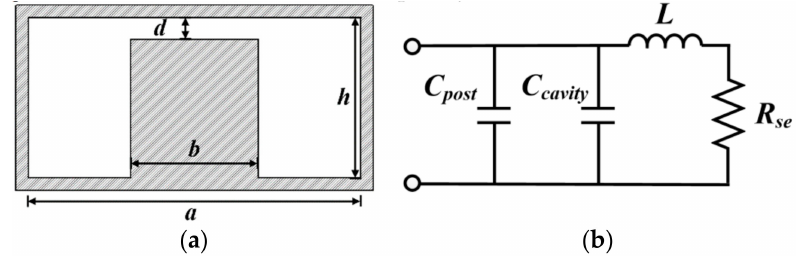
Figure 2. ( a ) Cross section of the square re-entrant cavity and ( b ) its equivalent